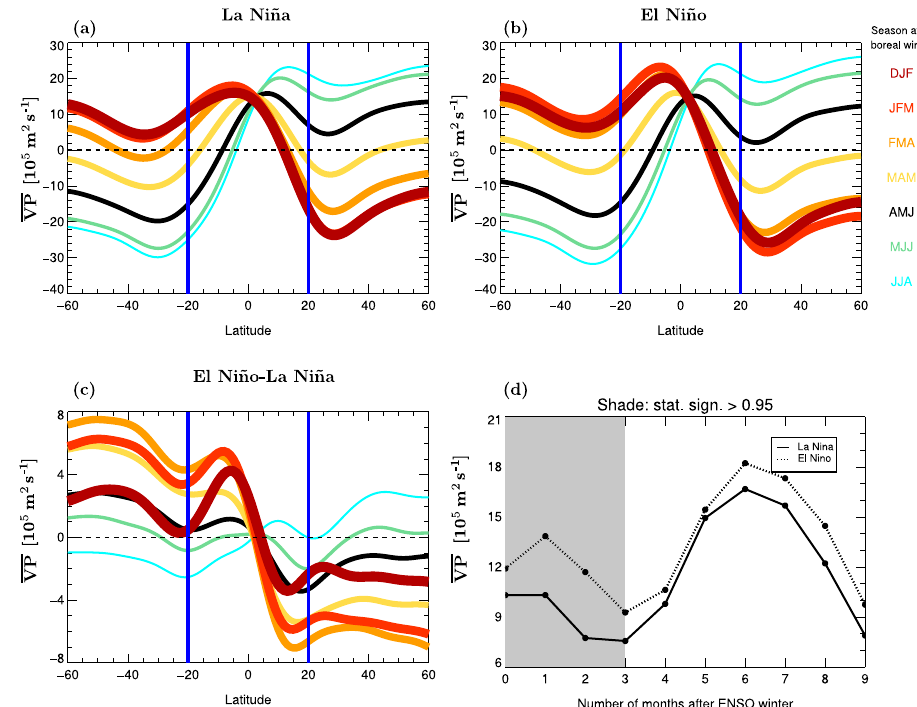
Figure 6. Zonal mean of the velocity potential at θ = 360K defining the Hadley circulation and calculated for La Niña (a) and El Niño composites (b) . The difference between La Niña and El Niño composites (c) . The average intensity of the Hadley circulation calculated for the domain of 20 ◦ S–20 ◦ N (d)